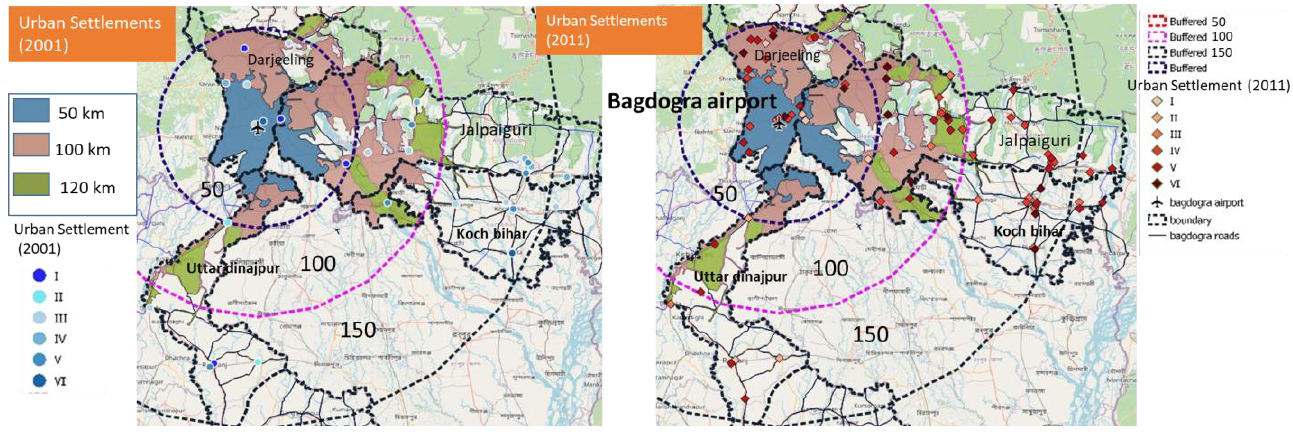
Figure 5. Hierarchy of settlements. Table 2. Emergence of urban